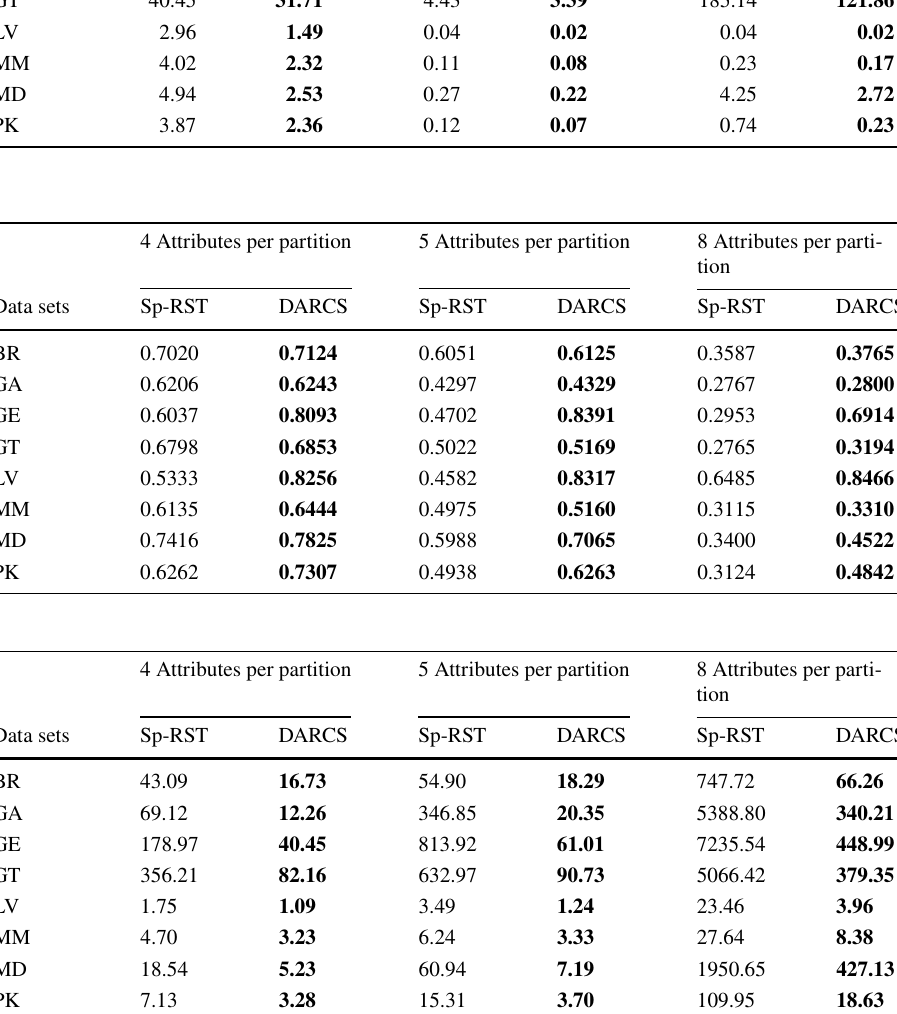
Table 6 The execution time of the classifiers comparison under 8 attributes per partition (unit: second)